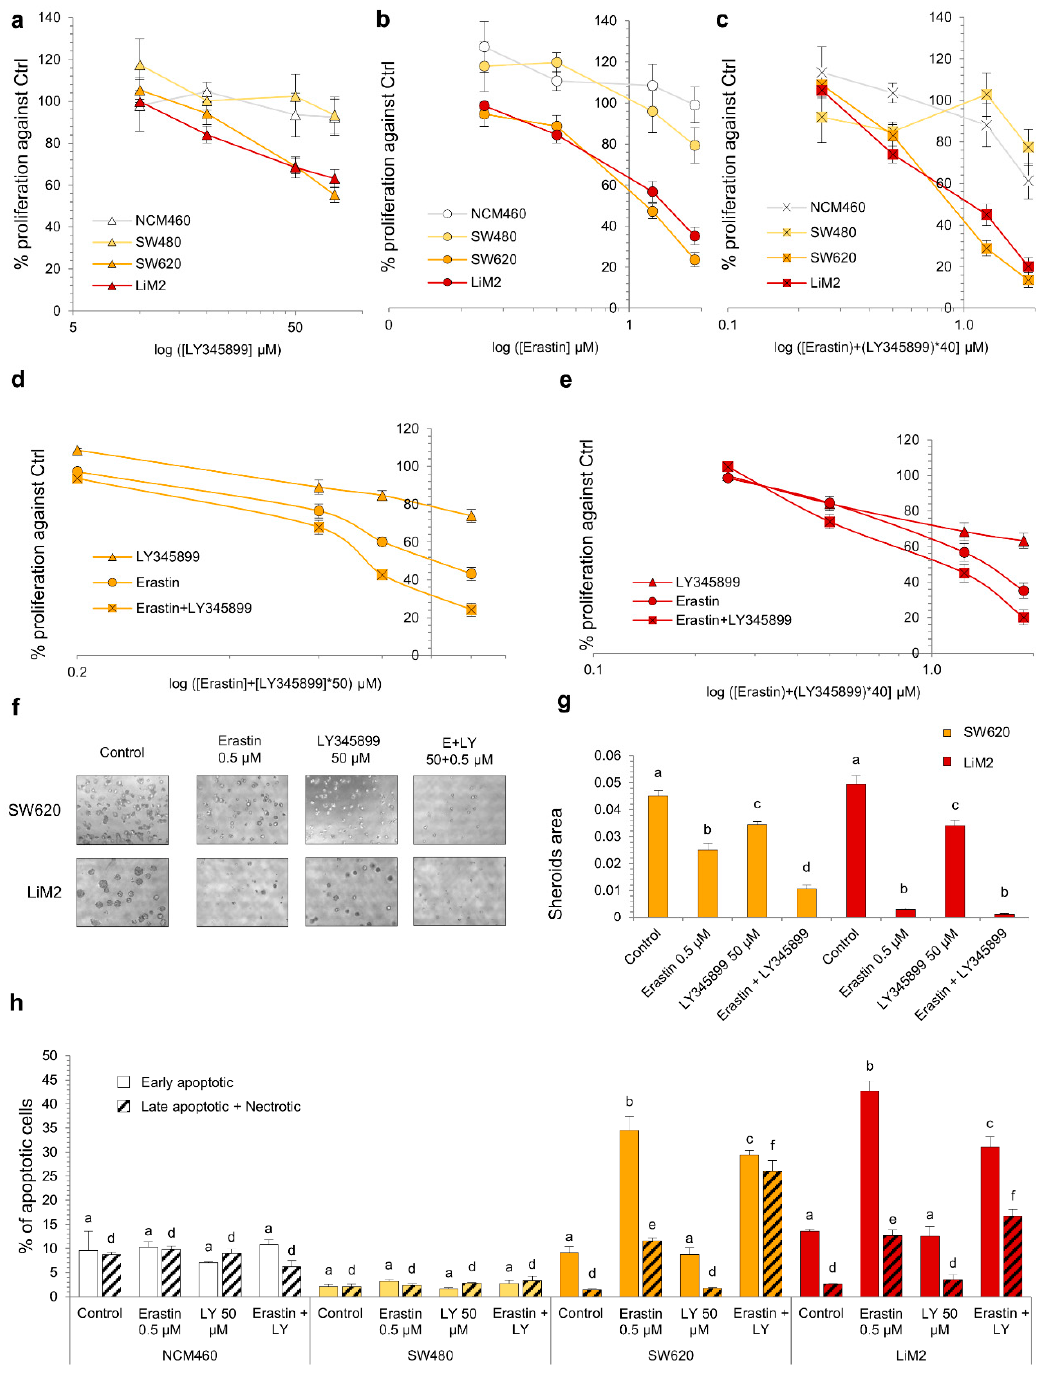
Figure 7. Synergistic effect of the simultaneous inhibition of cystine uptake and folate metabolism. ( a – c ) Cell viability curve for LY345899 ( a ), erastin ( b ) and the combination of both inhibitors ( c ) assessed by DNA content after 72 h incubation. ( d , e ) Same experiment in ( a – c ) comparing the three treatments (erastin or LY345899 individually and the combination) for the different cell lines. ( f , g ) Spheroid formation assay with erastin (0.5 µ M), LY345899 (50 µ M) or the combination. ( f ) Images of contrast-phase microscope (40×) and ( g ) quantification of spheroid area from scanner images. ( h ) Percentage of early apoptotic cells measured by flow cytometry using Annexin V-PI under erastin (0.5 μ M), LY345899 (50 μ M) or the combination after 72 h incubation. a–f A one-way ANOVA and Scheffe’s test for multiple comparisons was performed for the factor “drug treatment”. The statistical analyses for the drug combinations are shown in Table S4.